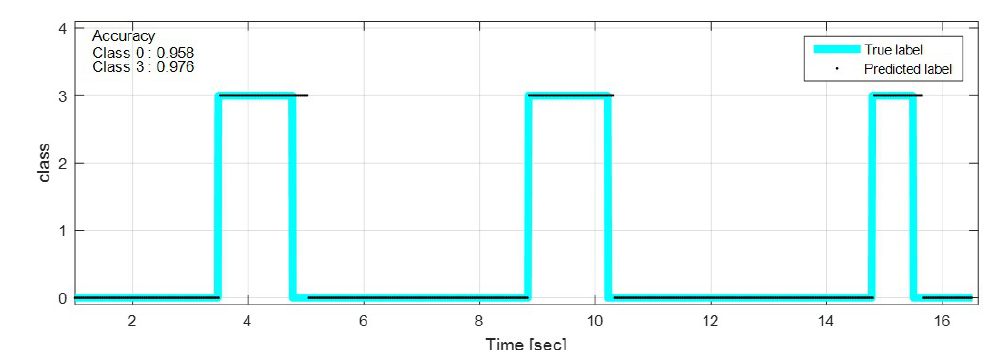
Figure 18. Prediction result on bump road, 35 km/h.